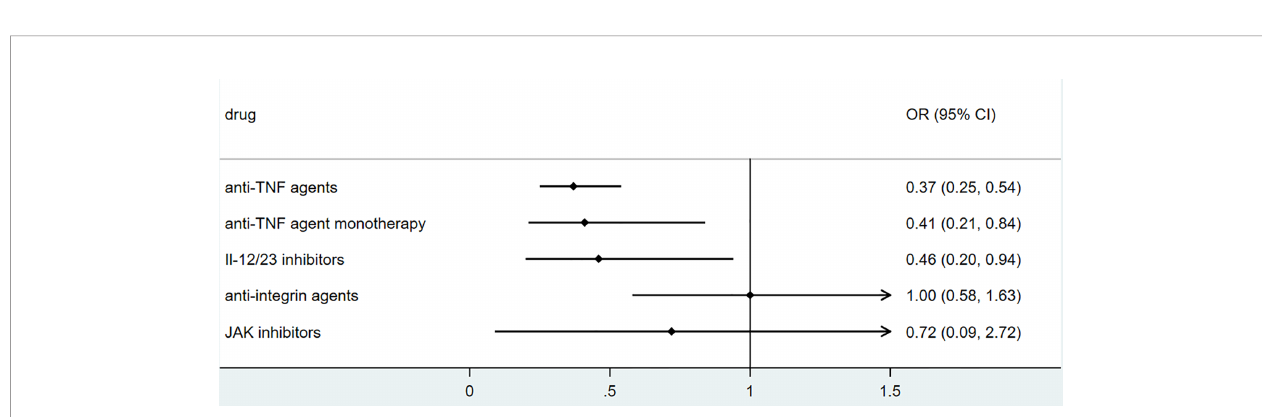
FIGURE 2 | The association of biologics and hospitalization rate among IBD patients with COVID-19 according to data from SECURE-IBD (27). [The group ‘ anti- TNF agent monotherapy ’ was compared to the group receiving anti-TNF agent combined with 6MP/AZA/MTX. The other groups ( ‘ Anti-TNF agents ’ , ‘ IL-12/23 inhibitors ’ , ‘ Anti-integrin agents ’ and ‘ JAK inhibitor ’ ) were compared to those did not receive the corresponding biologics].